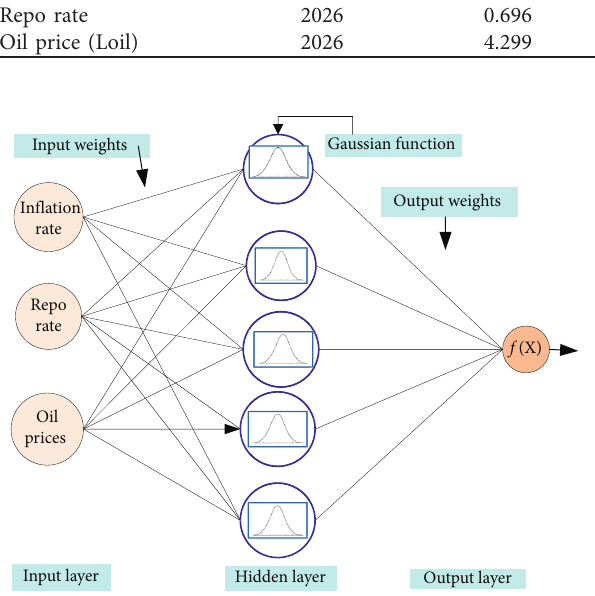
Figure 1: Radial basis function neural network mechanism.